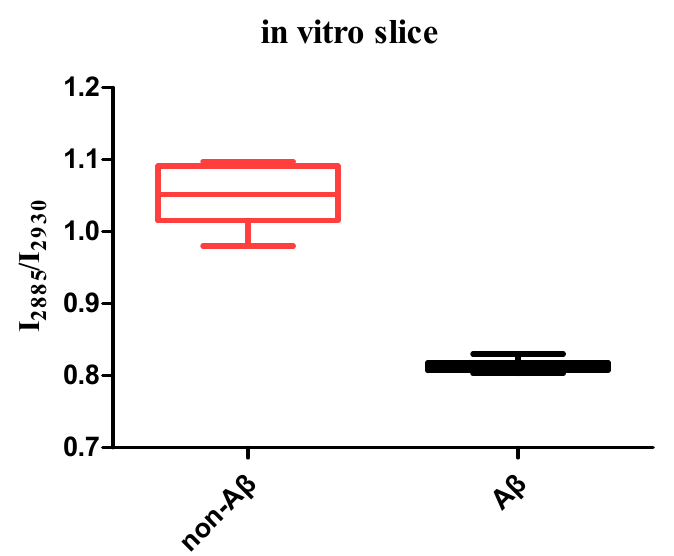
Figure 3. Comparison of typical normalized CARS spectra of the non-A β region (blue line) and A β region (red line) in the C – H stretching vibration region. Both spectra exhibited two peaks at 2850 and 2930 cm –1 . The standard errors are indicated by the horizontal solid lines.